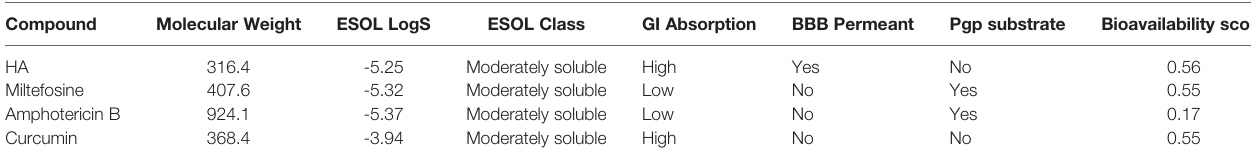
TABLE 4 | Prediction of pharmacokinetic properties for HA, miltefosine, amphotericin B and curcumin using SwissADME. Compound Molecular